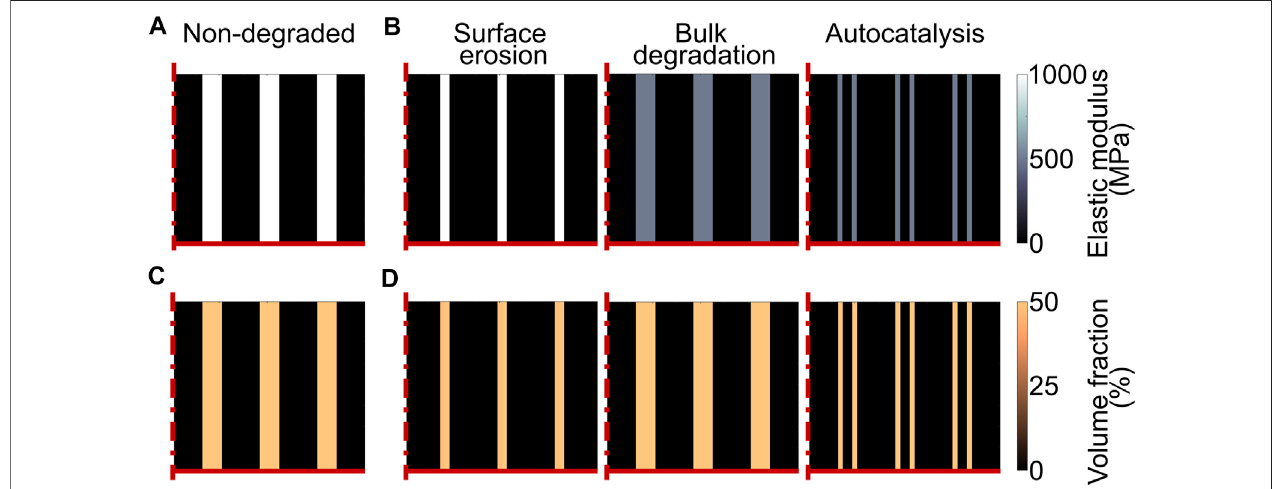
FIGURE 2 | Model of scaffold degradation in osteochondral defect. (A) and (C) Elastic modulus and volume fraction, respectively, of the scaffold material prior to degradation; (B) and (D) Elastic modulus and volume fraction, respectively, of the “ arti fi cial ” scaffold with matched degradation speed at day 25 (complete scaffold degradation set to day 50). The left, middle, and right columns show the scaffold degrading by surface erosion, bulk degradation, and bulk degradation with autocatalysis, respectively. At the time point shown in the plots, the surface and bulk elements of the scaffold degrading by surface erosion and bulk degradation with autocatalysis, respectively, were completely degraded. The dash-dot and solid red lines mark the axis of symmetry and the articular interface, respectively. The legends to interpret the plots are on the right side of the corresponding rows. The volume fraction is expressed as percentage of the total volume in one element.